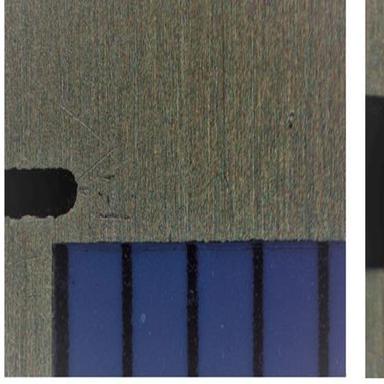
Captured photographs of the crack configuration at different locations along the path of mode I crack propagation.